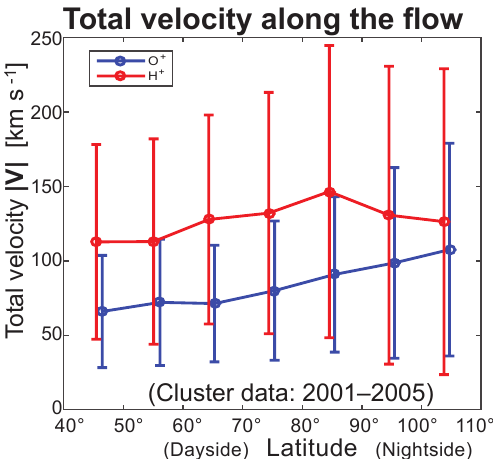
Figure 2. Bulk velocity profiles of H + (red) and O + (blue) along the average O + flow direction over plasma mantle as defined by Fig. 6 of Slapak et al. (2017) and obtained from the same statistics (Cluster, 2001–2005). Error bars defined by the standard deviation are